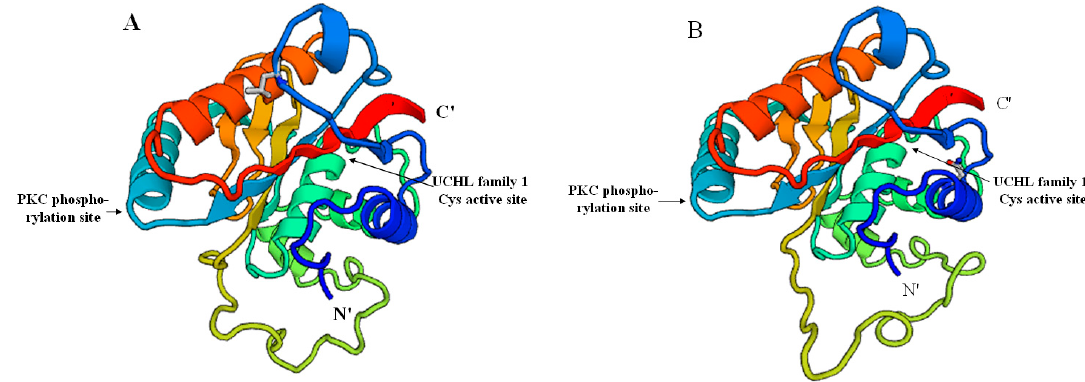
Figure 3. The predicted three-dimensional structure of Sp -UCHL3 ( A ) and Pc- UCHL3 ( B ).